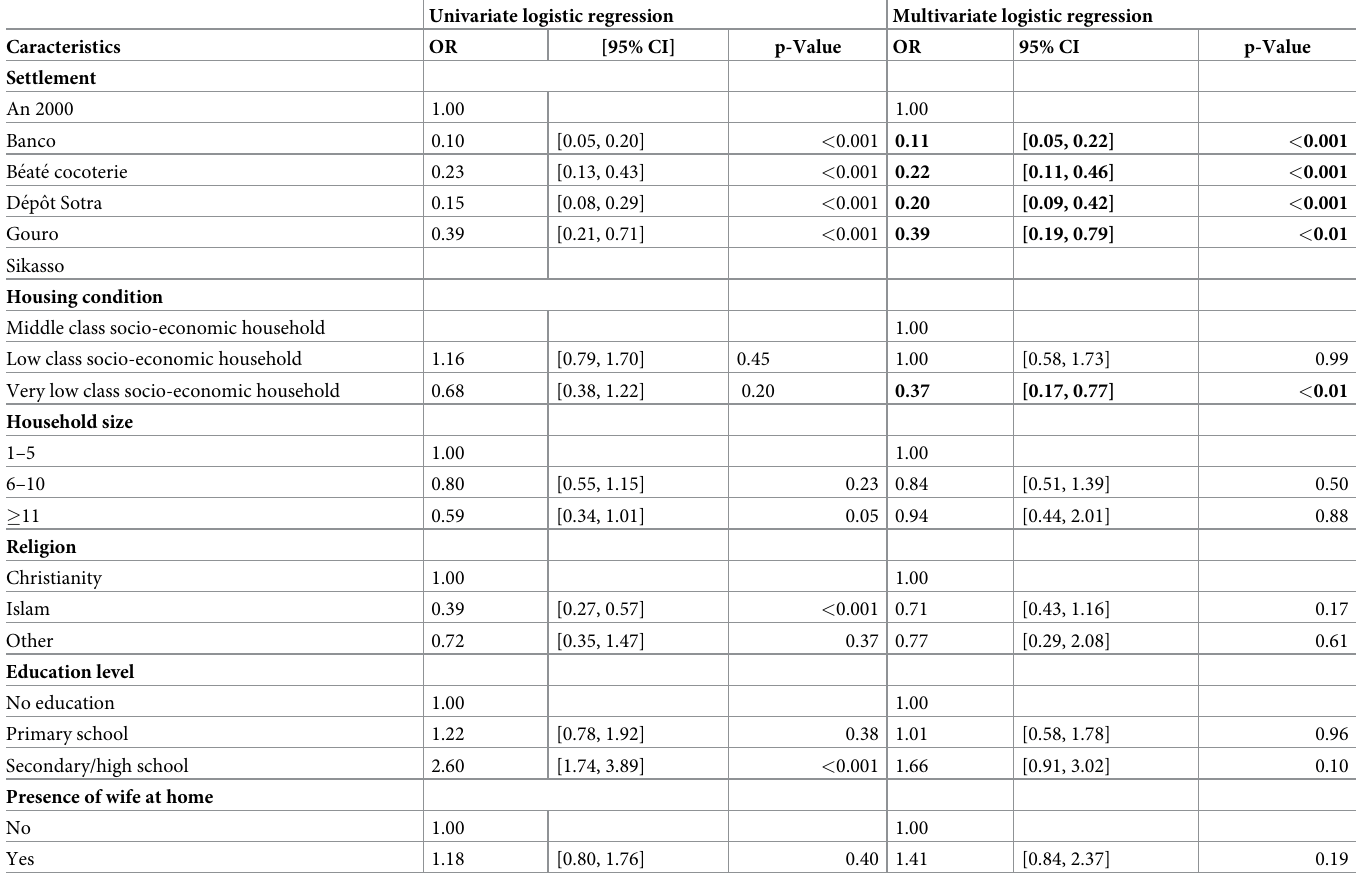
Table 4. Univariate and multivariate logistic regression for associations between identified factors and access to improved sanitation in settlements investigated in